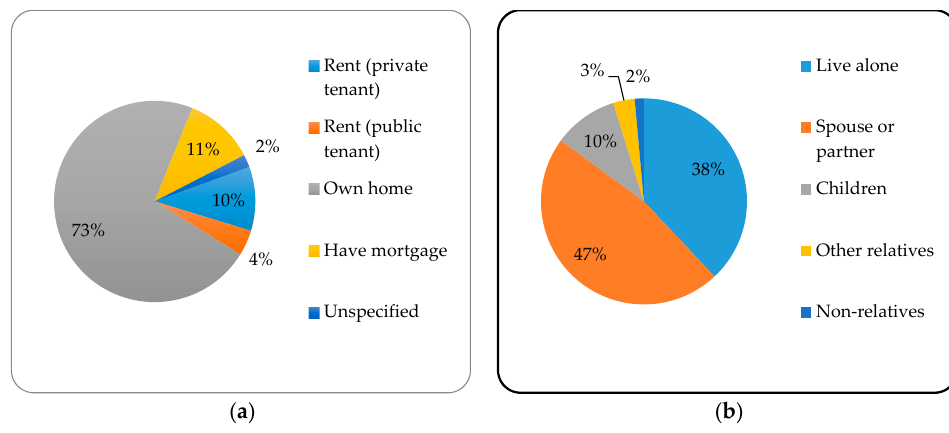
Figure 4. Participants’ ownership of the housing ( a ) and living status ( b ).